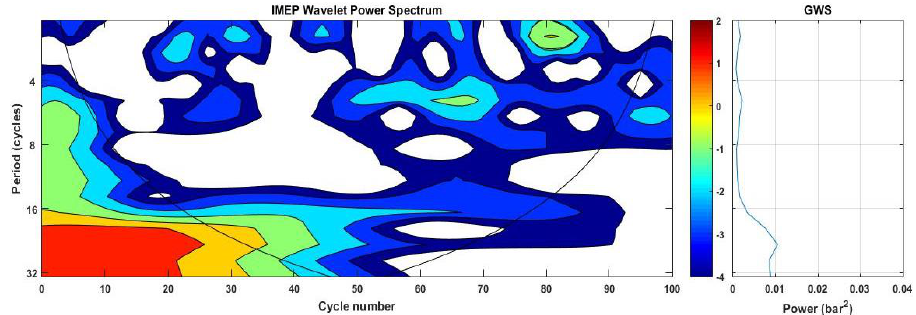
Figure 5. Wavelet analysis of IMEP (WPS and GWS), 10MPa_240BTDC_1500_Foul.